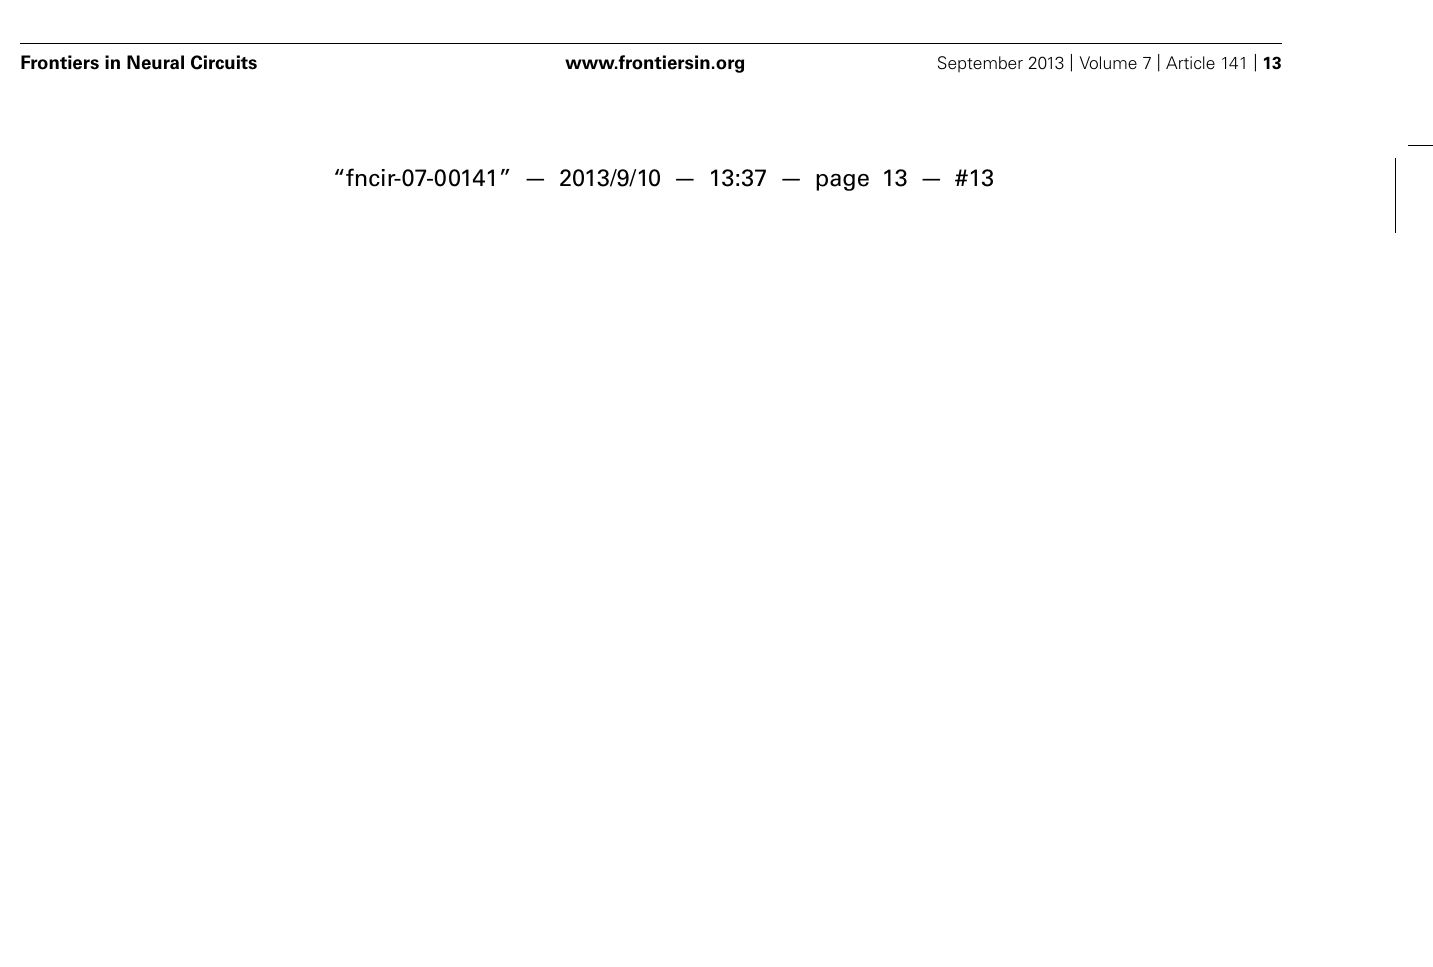
deviations, respectively. (C) Peri-burst time histograms (PETHs) of median multiunit firing activity during control and 250 nM muscimol ( n = 9, paired data). (D) , AUROC and bootstrapped 95% confidence intervals (shown only for 250 nM) for the bin-by-bin comparison of PETHs during control and drug application. Same conventions apply as in Figures 3C,D